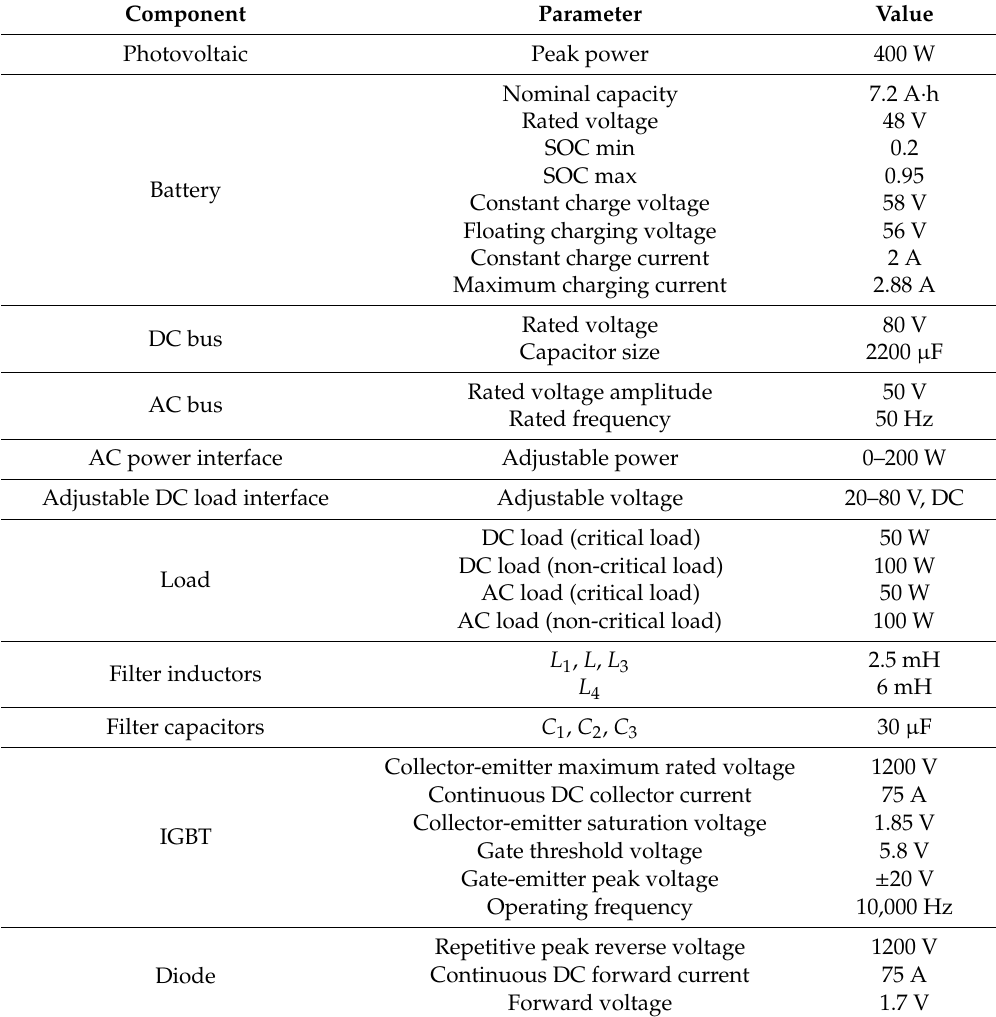
Table 1. Parameters of each part of